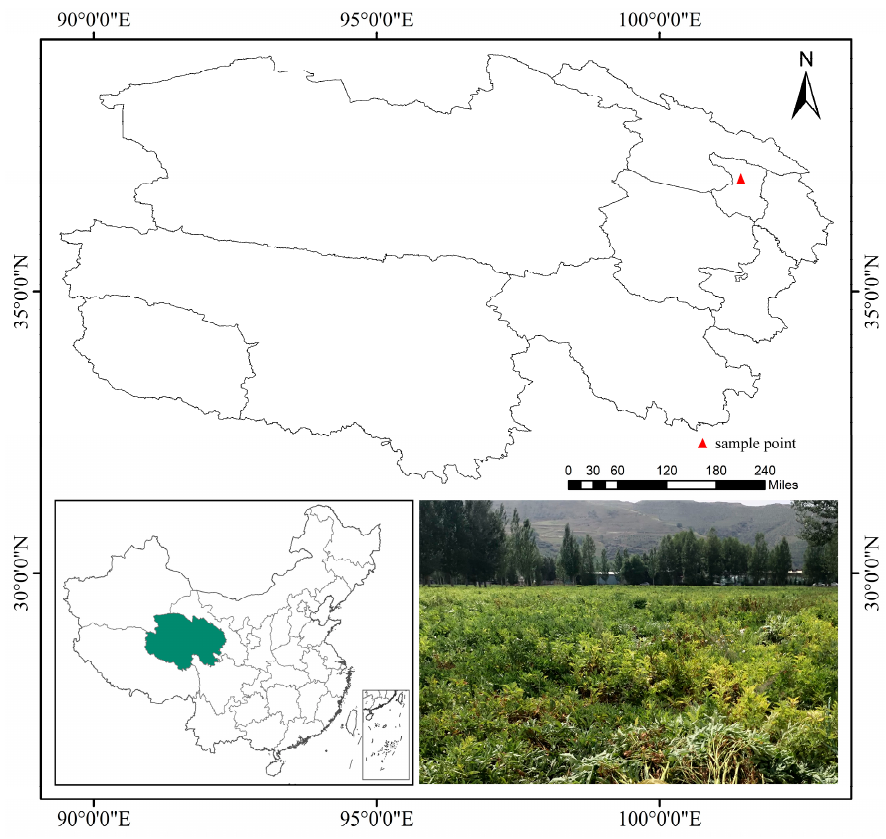
Figure 6. Location map of the test site.